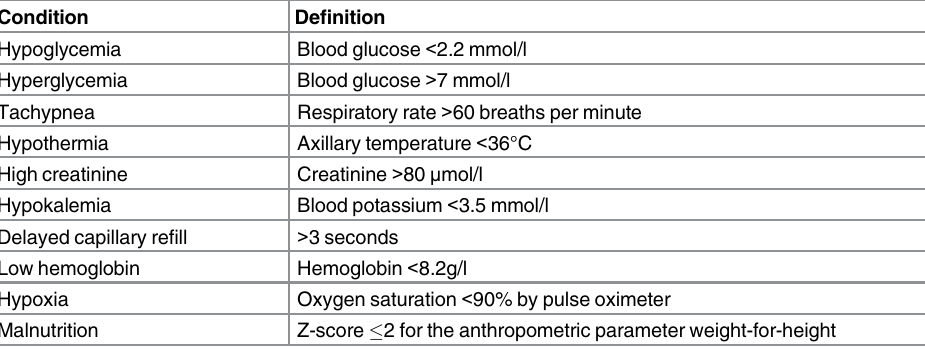
Table 1. Clinical definition of the variables.